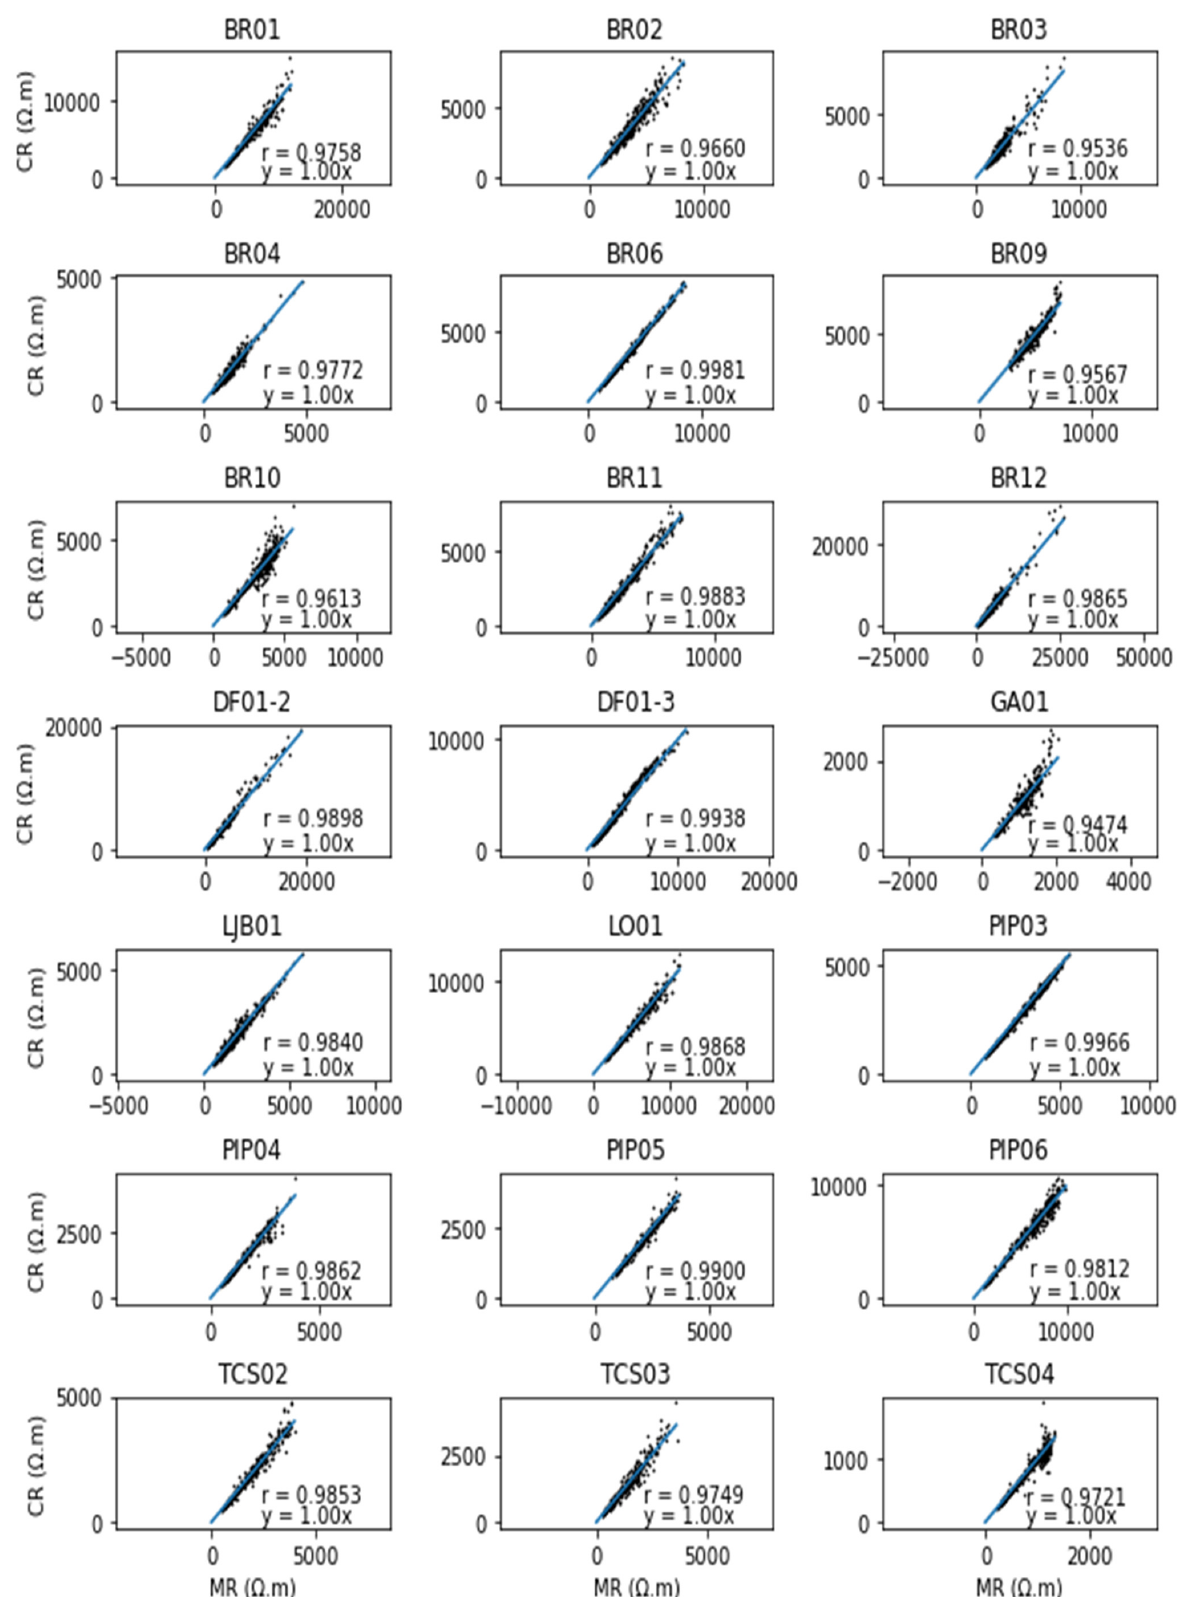
Figure 6. The relationship between calculated and measured resistivity at twenty-two ERT profiles. The abbreviations CR and MR stand for calculated and measured resistivities,